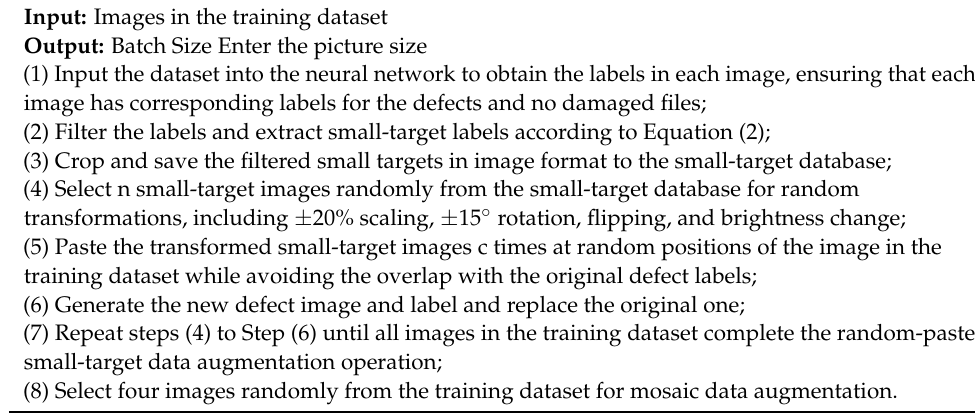
Algorithm 1: Random-Paste-Mosaic (RPM) Small-Target Data Augmentation Algorithm